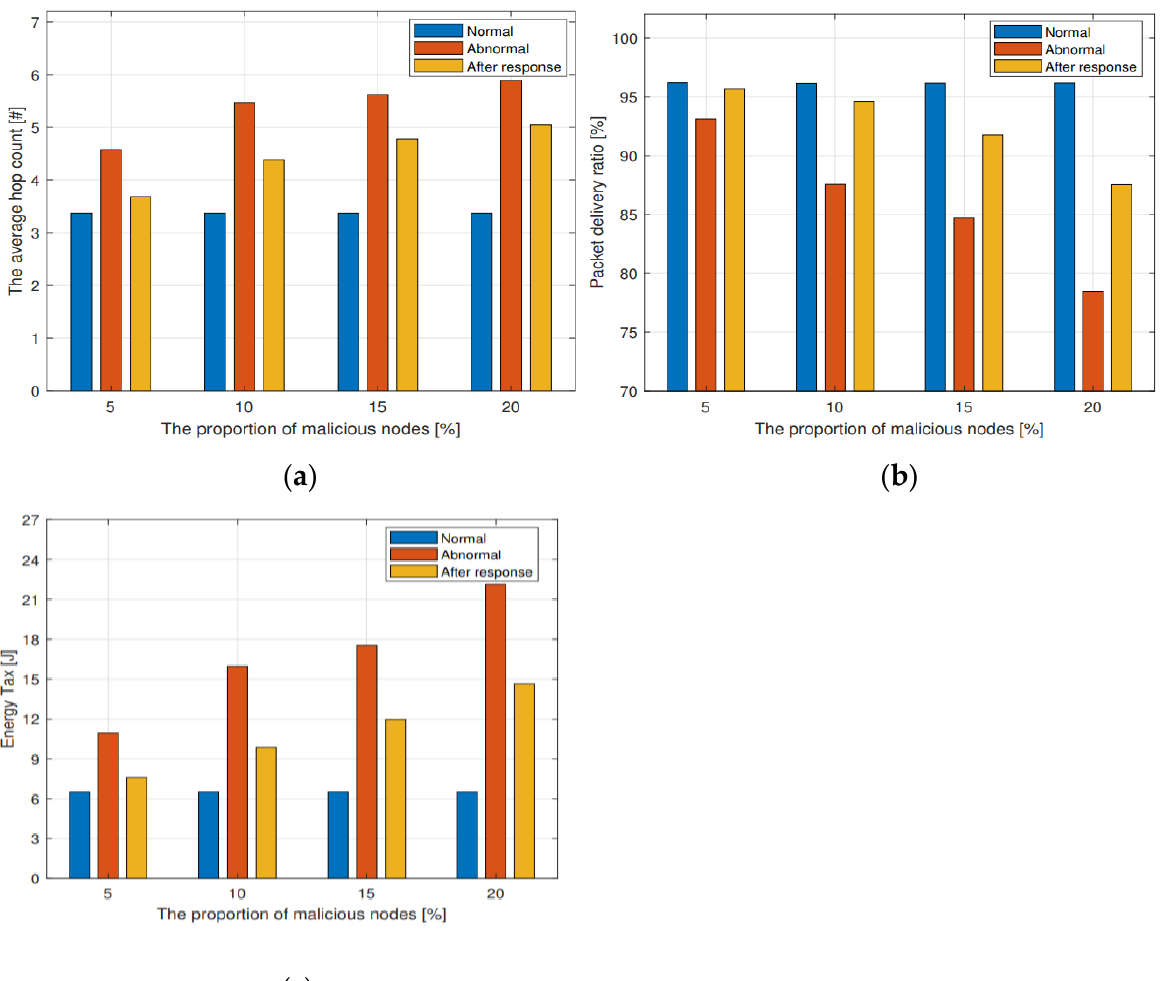
Figure 10. ( a ) The influence of DOIDS on the average hop count; ( b ) The influence of DOIDS on the packet delivery ratio; ( c ) The influence of DOIDS on the energy tax;